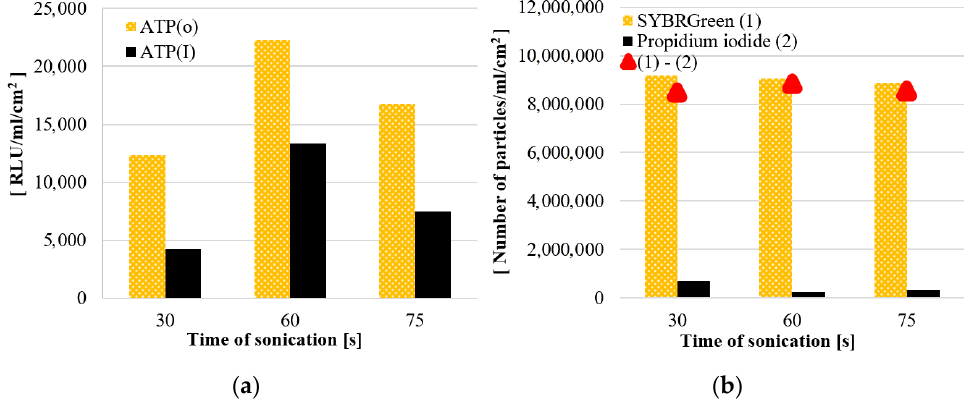
Figure 1. Average ATP value ( a ) and average number of microorganisms measurement by flow cytometry ( b ).